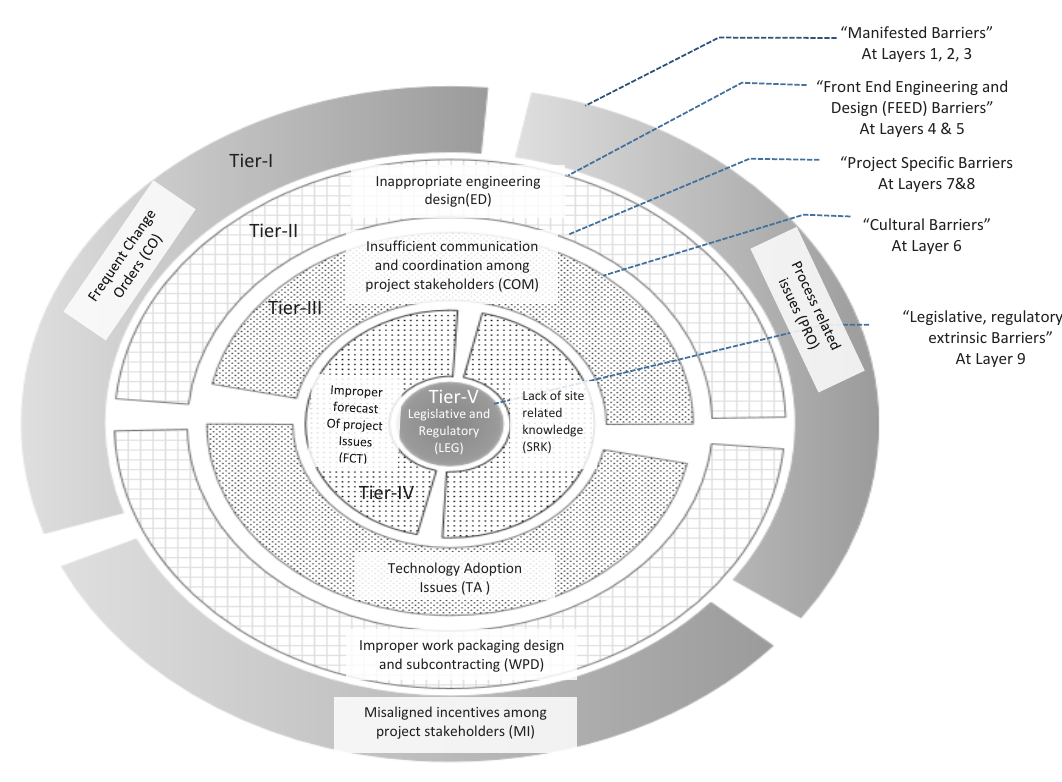
Figure 4. Multi-Layered IM implementation related